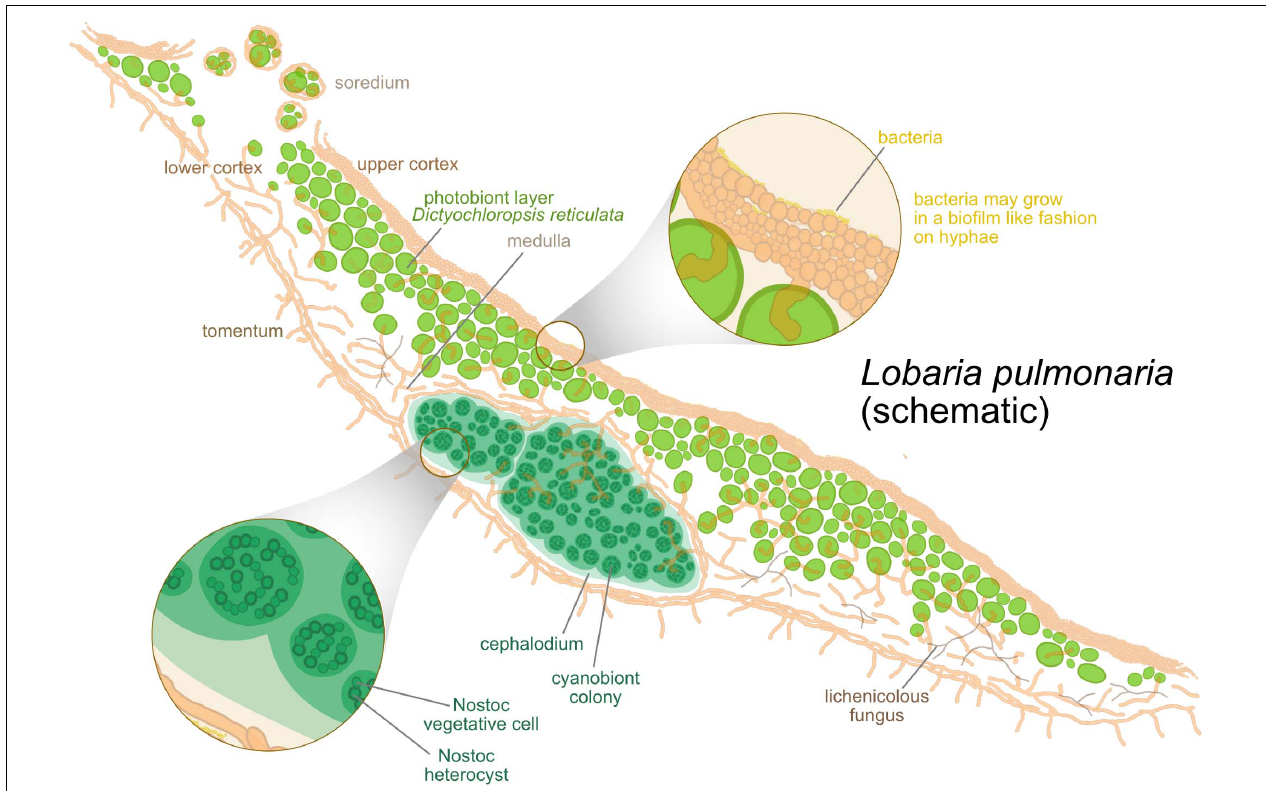
FIGURE 1 | Schematic anatomical structure of lichens, with Lobaria pulmonaria as an example. Algae are hosted in a layered fungal scaffold structure delimited by an upper and a lower cortex. Green algae form a layer under the upper cortex. Below the algal layer, a hydrophobic medulla facilitates gas exchange within the thallus. As a tripartite lichen, L. pulmonaria hosts clusters of cyanobacteria inside the thallus in addition to the algae.